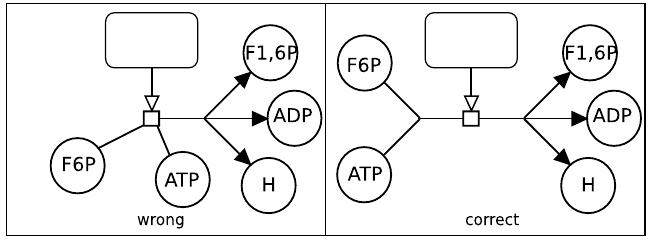
Figure 4.6: Arcs between a process and the consumption and production arcs must be at- tached to the center of opposite sides, modulatory arcs must be attached to the other two sides.